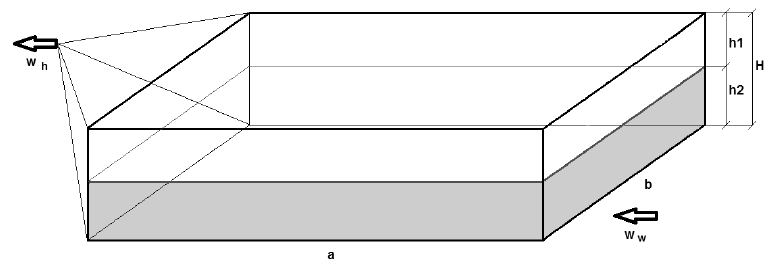
Figure 2. Iceberg calculation scheme (own elaboration), where: w h —tug speed, w w —current speed, H—total height of the iceberg, h1 — height of the above-water part of the iceberg, h2—height of the underwater part of the iceberg (own elaboration).